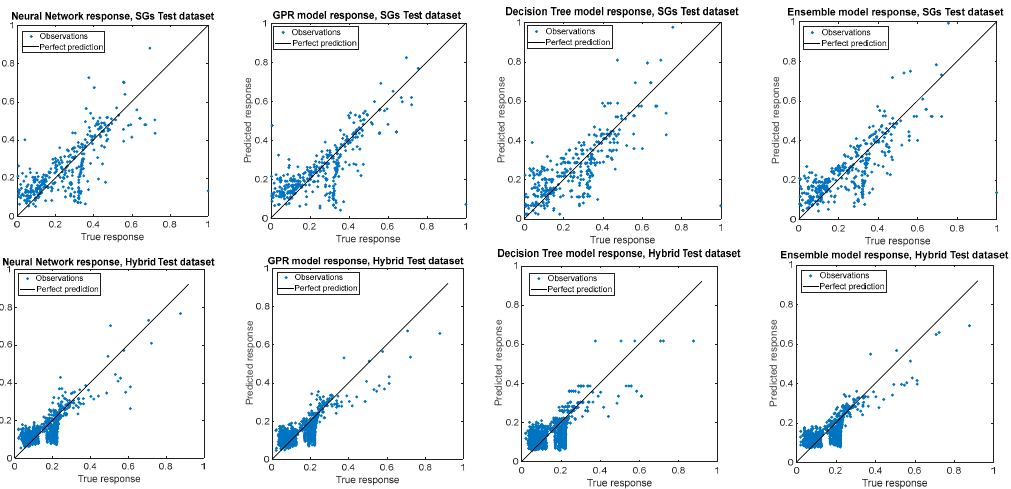
Figure 16. True and predicted responses by four optimized regression models trained by SG and hybrid datasets. Table 6. Performance measures of each model considering both approaches in training and test phases.